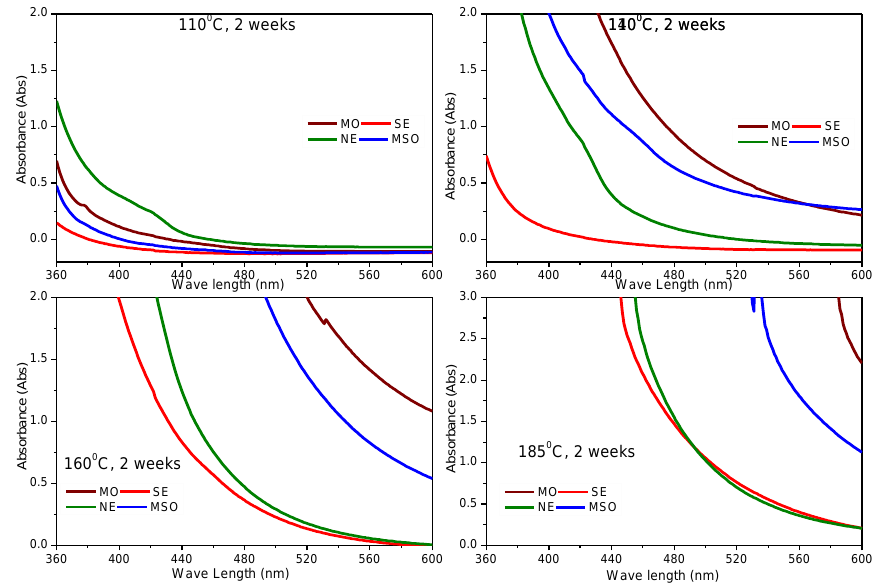
Figure 11. UV Spectral curves of oils indicate the degree of degradation.